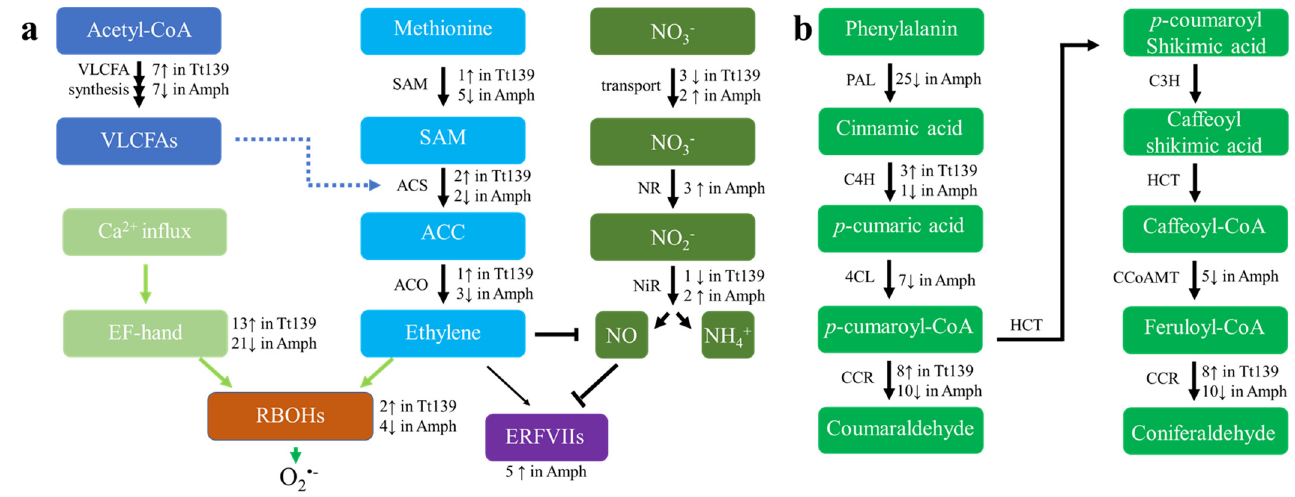
Figure 5. Genetic pathways and differentially expressed genes in root tips in response to hypoxia stress. ( a ) Part of the VLCFA, ethylene, ROS, and NO biosynthesis pathways and ( b ) part of the lignin biosynthetic pathway are presented with enzymes or proteins indicated at the left and numbers of the transcripts upregulated ( ↑ ) or downregulated ( ↓ ) by stagnant treatment in Tt139 and Amph819 (Amph) indicated at the right. In the genetic pathways, arrows between components indicate stimulation of activities at protein (bold arrows) or transcription level (fine arrow), and the T-bars indicate inhibition. The fold change of the transcripts can be found in Table S8.